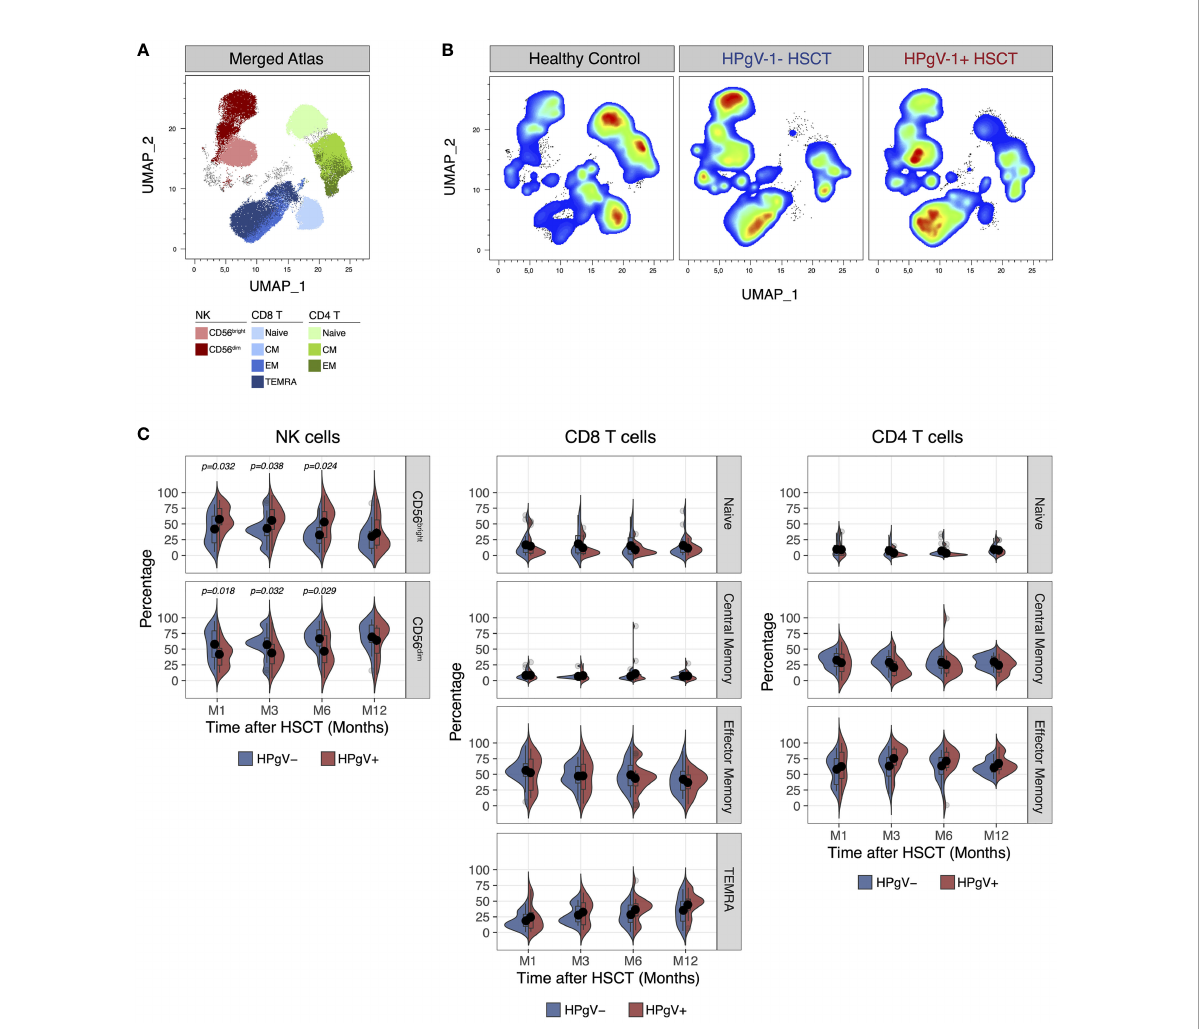
FIGURE 2 Impact of HPgV-1 viremia on lymphocyte subsets distribution after allogeneic HSCT. (A, B) Uniform Manifold Approximation and Projection (UMAP) plots of FACS data obtained from the analysis of live non-B cell lymphocytes recovered from a representative healthy donor, a HPgV-1- and a HPgV-1+ HSCT recipient at 6 months after allogeneic HSCT. Distribution of cell subsets identi fi ed by manual gating is shown in the merged atlas (A) combining all samples. (C) Split-violin plots showing the percentage of the indicated cell subsets among NK (left panels), CD8 (middle panels) and CD4 (right panels) T cells in HPgV-1- (blue violins) and HPgV-1+ (red violins) HSCT recipients. Results in the two patient groups were compared using a nonparametric Mann-Whitney U